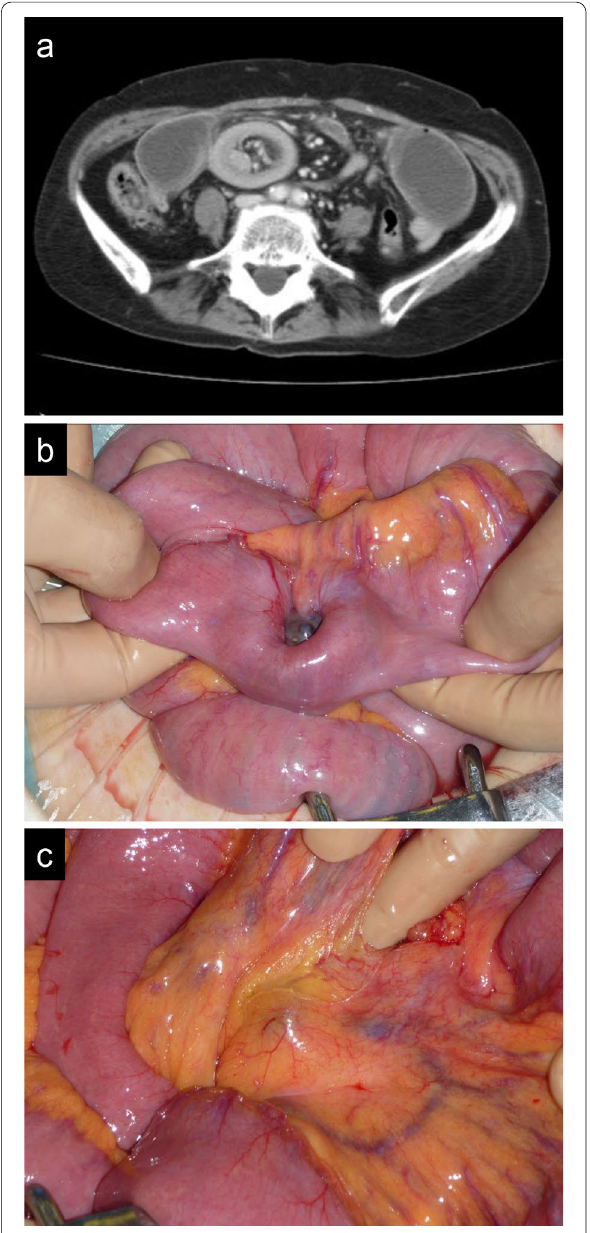
Fig. 3 a Computed tomography showing a mass in the cervical esophagus. The yellow arrowhead indicates a mass found in the cervical esophagus. b Endoscopy showing the elevated lesion in the cervical esophagus. The yellow arrowhead indicates the site of esophagogastric anastomosis. c Resected specimen after cervical esophagectomy. A black mass is found in the cervical esophagus. The yellow arrowhead indicates the esophagogastric